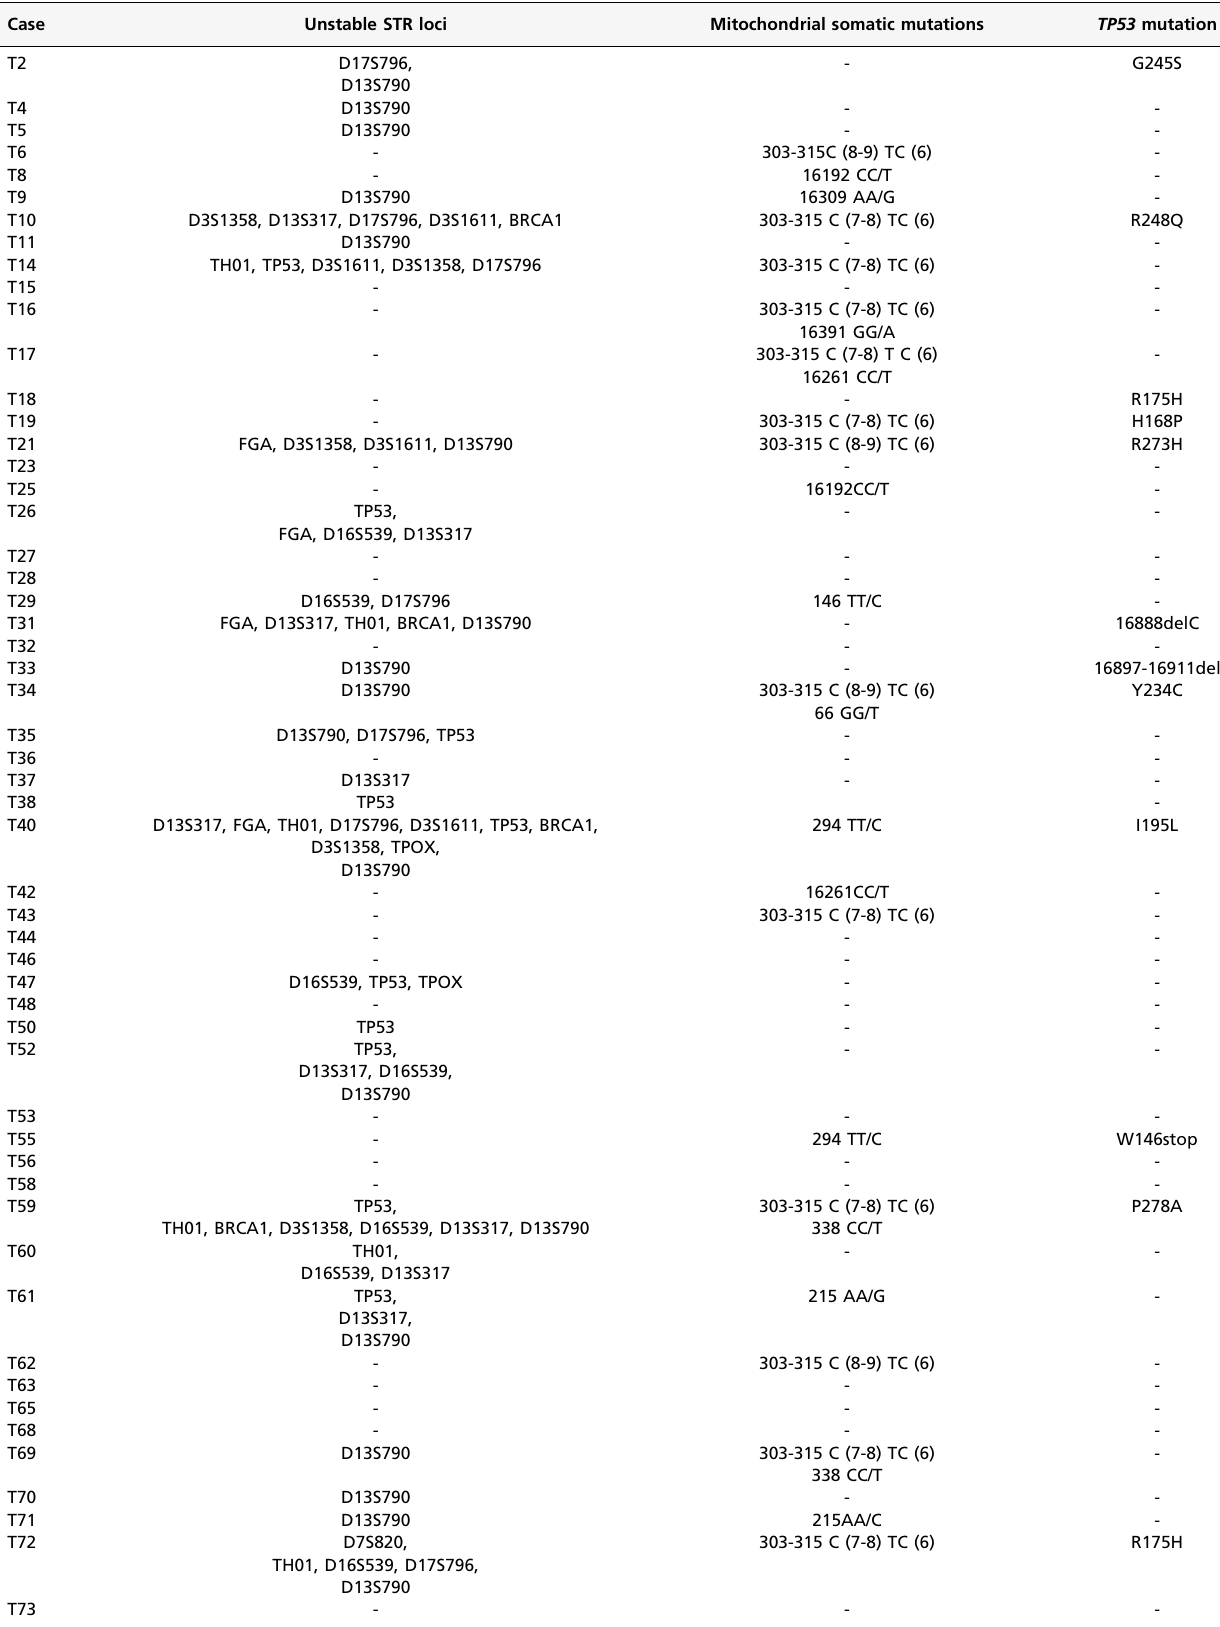
Supplementary Table 4 - Unstable STR loci, mtDNA mutations and TP53 mutation status (exons